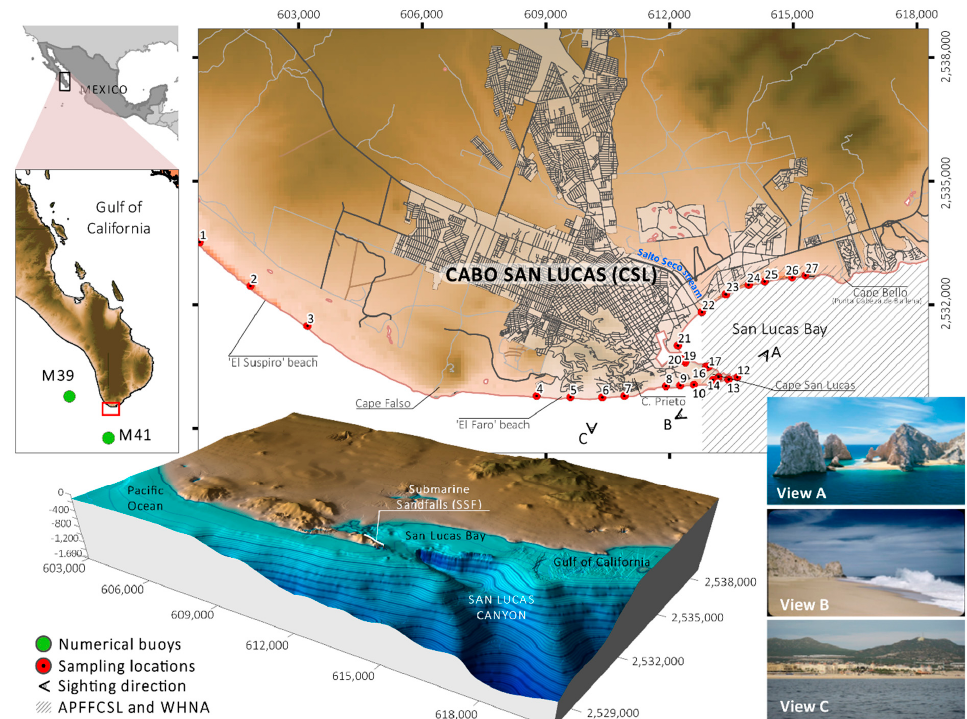
Figure 1. Location of Cabo San Lucas, the submarine sand falls, the San Lucas Canyon, and the natural protected areas APFFCSL and WHNA. Beaches, capes, and hills along the shoreline are also shown, along with sand sampling sites, numerical buoys, and views of the rocky outcrops of Los Frailes and the Arch of Cabo San Lucas ( A ), sand strips forming the passage between the Pacific Ocean and San Lucas Bay ( B ), and hotel developments ( C ).